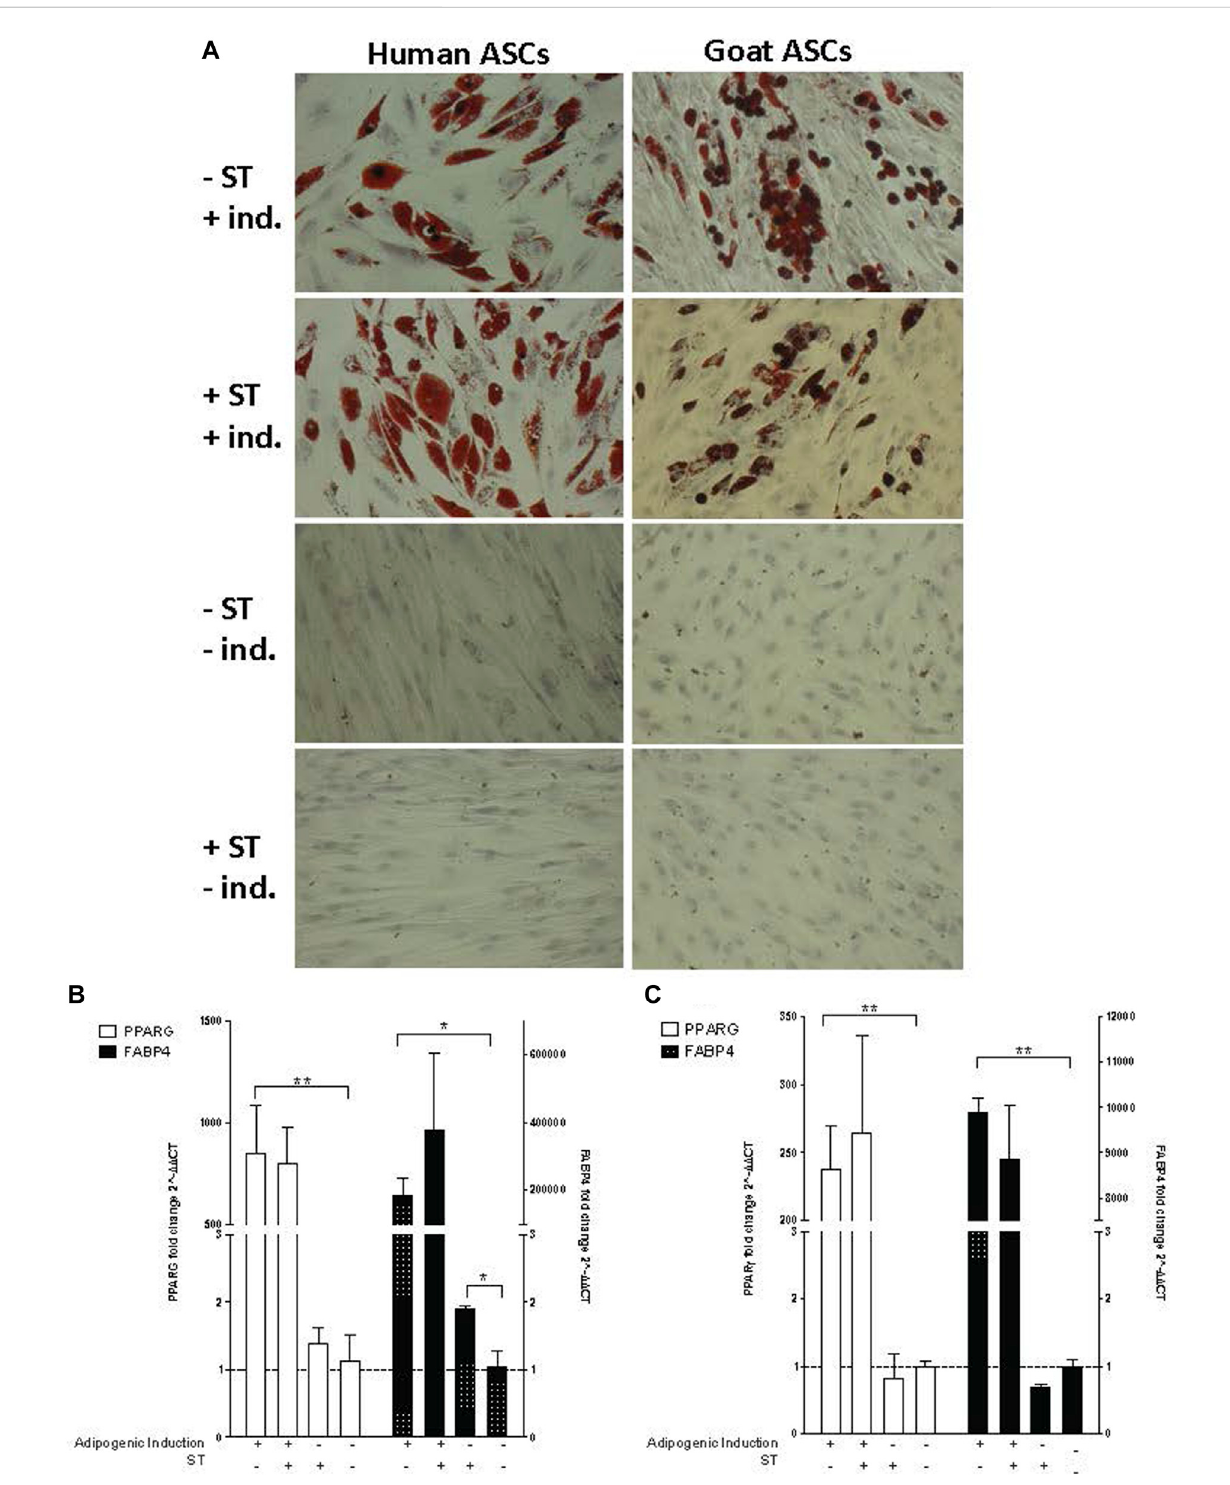
FIGURE 6 Adipogenic induction. Representative images are shown in bright fi eld at ×200 magni fi cation. (A) Oil Red O staining of adipogenic differentiation in ASCspost-microbialassociation.hASCsand gASCs werecultured inadipogenic induction medium for 21 daysand stainedwith OilRed O.Accumulation of cytoplasmiclipid droplets wereobserved inASCs induced for adipogenesis, independentof S.T treatment. S.T-treatedand non-treated ASCs cultured in control medium did not yield lipid-positive cells. Expression of adipogenic markers in ASCs post-microbial association was analyzed via quantitativePCRanalysisofPPAR γ andFABP4expressionin (B) humanand (C) goatASCsinducedwithadipogenicinductionmediumand/ortreatedwith S.T. Data is presented as fold change (±SEM) relative to expression levels in non-treated, non-induced cells (fold change ~1, indicated by the dotted line). Statistical signi fi cance of p < 0.05 is denoted by an asterisk (*), and p < 0.01 denoted by two asterisks